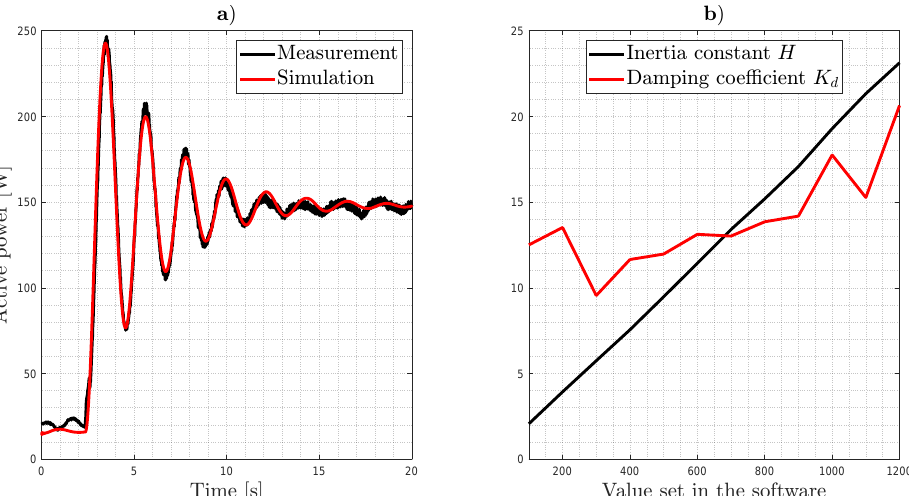
Figure 6. ( a ): Active power of the simulation (red) and measured active power (black) after conver- gence of the parameter estimation tool for a value of 600 defined in the software. ( b ): Inertia constant H in seconds and damping coefficient K d in pu depending on the value set in the software.